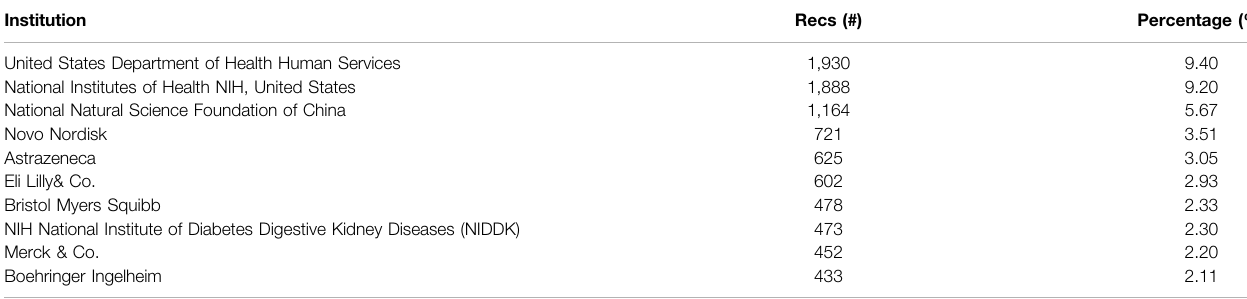
TABLE 2 | The top 10 productive funding agencies in metformin area.